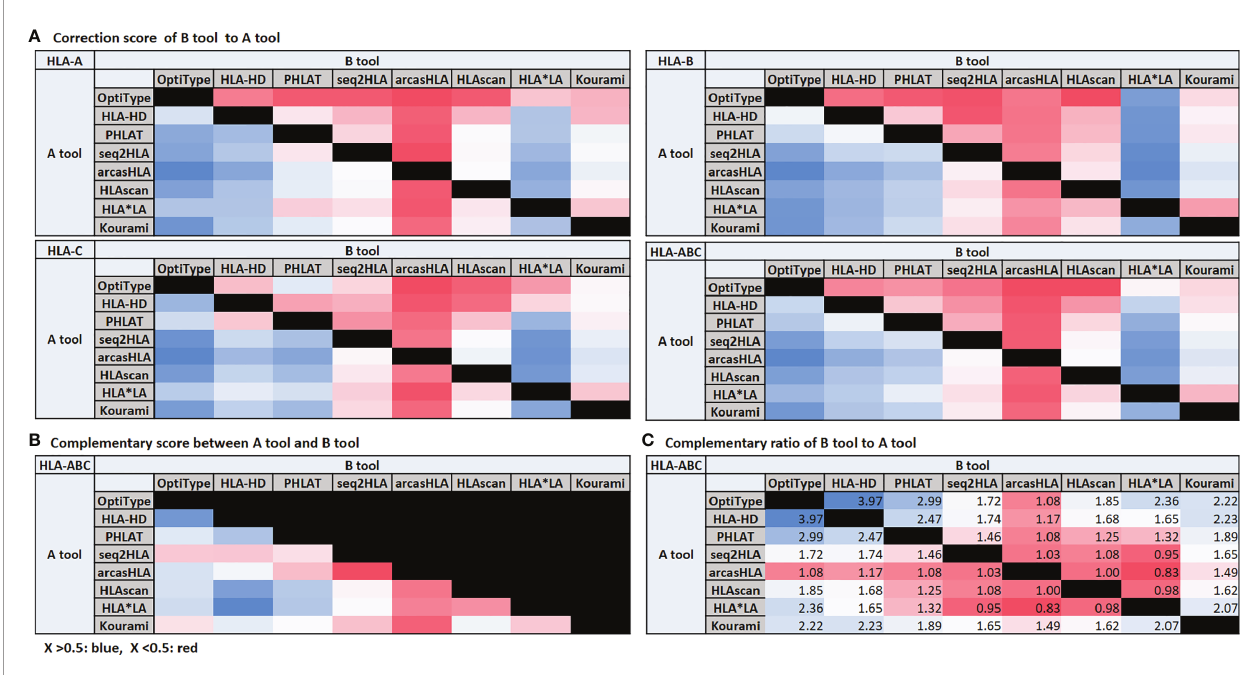
FIGURE 4 | Correction score (A) and complementary score (B) . The correction score is calculated by measuring how much the calls of other tools match the reference when a call of one tool is wrong. Assuming that there are tools (A, B) , the correction score of (B, A) is the degree to which the call of (B) is correct when the call of (A) is incorrect. The degree to which the call of (A) is correct when the call of (B) is incorrect is the correction score of (A, B) . The average of these two scores is the complementary score between (A, B) . The complementary ratio (C) . The complementary ratio of (B, A) is obtained by additionally considering the accuracy of the tool with the correction